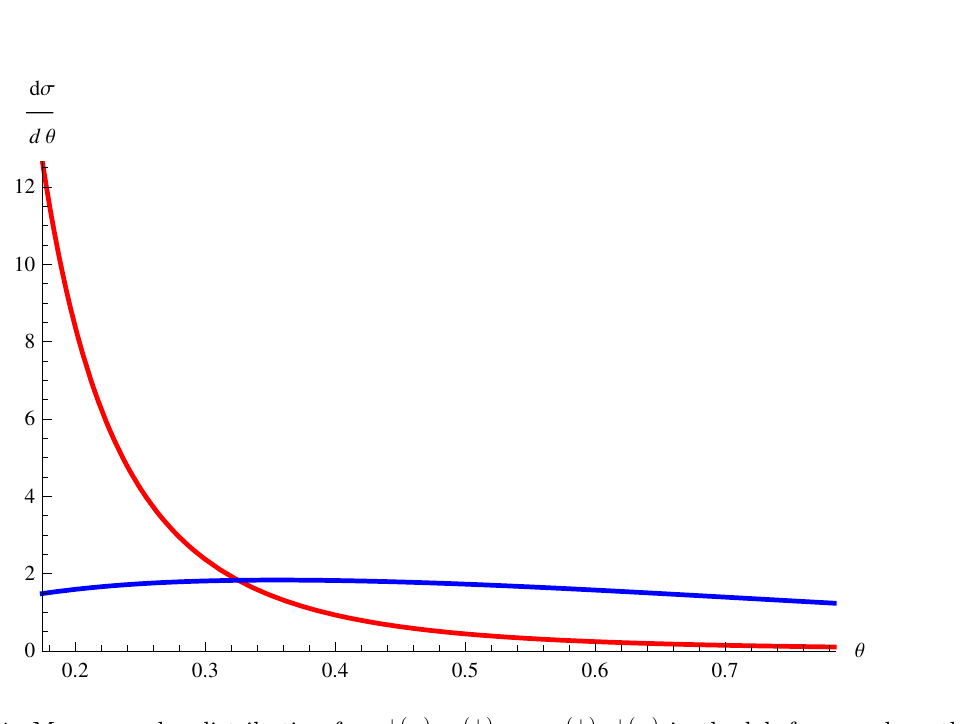
Figure 4 . Muon angular distribution for e +( (cid:0) ) (cid:22) (cid:0) (+) ! e (cid:0) (+) (cid:22) +( (cid:0) ) in the lab frame, where the minitial muon energy is 3 TeVs and the initial electron one is 200 GeVs. The red curve corresponds to a Z’ mass of 100 GeV, while the blue one corresponds to a Z’ mass of 3